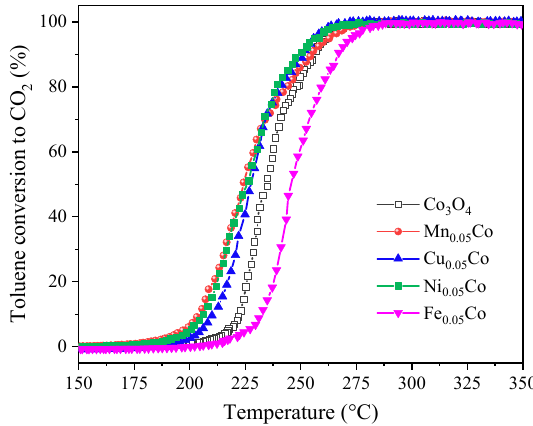
Figure 6. Variation of the toluene conversion with the reaction temperature during the third consecutive cooling run over the Co 3 O 4 and M 0.05 Co catalysts.